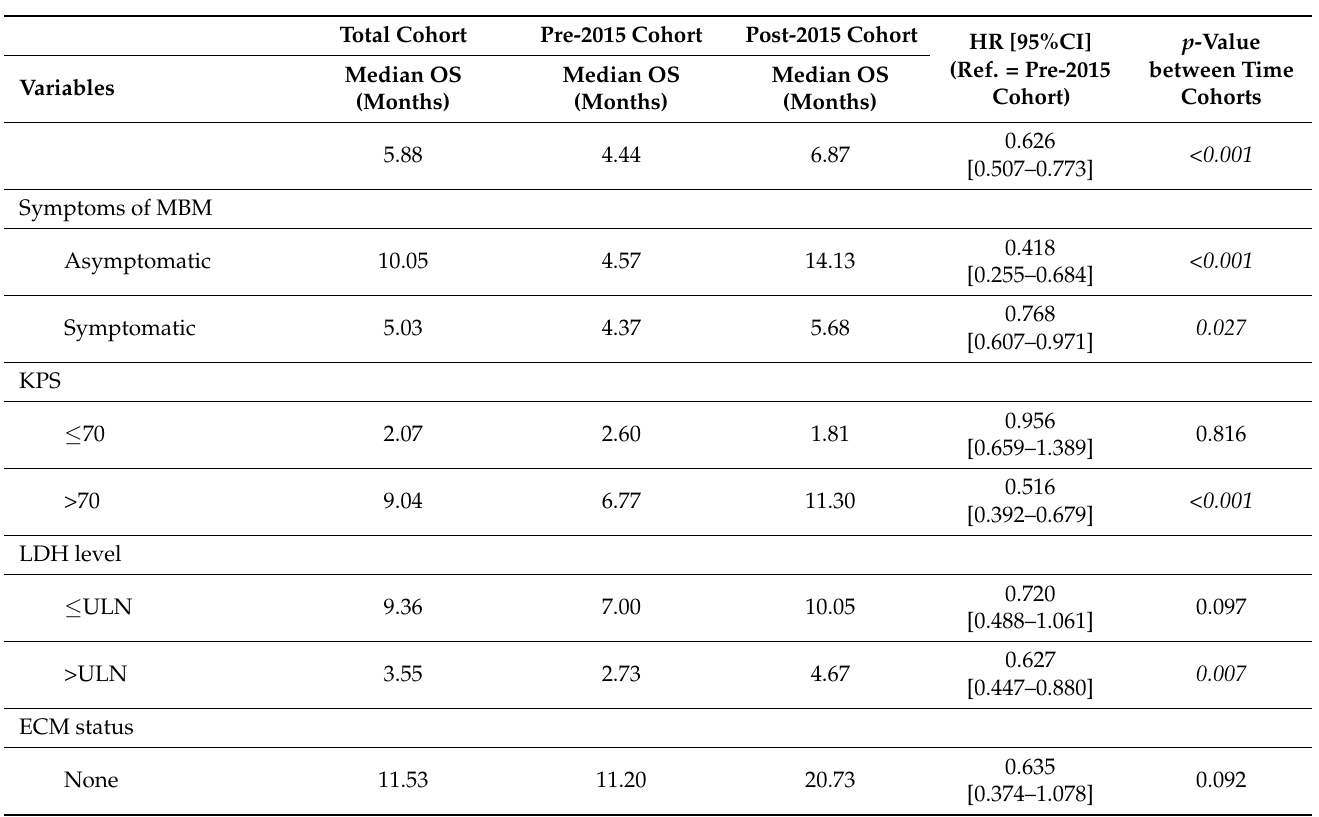
Figure A3. Number of started treatments each year at the Erasmus MC, at any time after diagnosis of melanoma brain metastasis. Table A2. Overall survival for subgroups of patients diagnosed with melanoma brain metastasis (MBM) in the total cohort ( n = 430), pre-2015 cohort ( n = 152) and post-2015 cohort ( n = 278). Significance testing was performed to compare the pre-2015 and post-2015 cohorts, with significant p -values (<0.05) in italic.